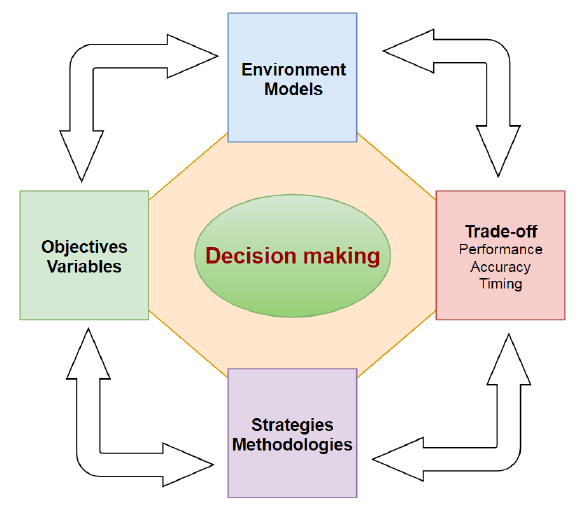
Figure 1. How to choose a good (best) decision for practical optimisation